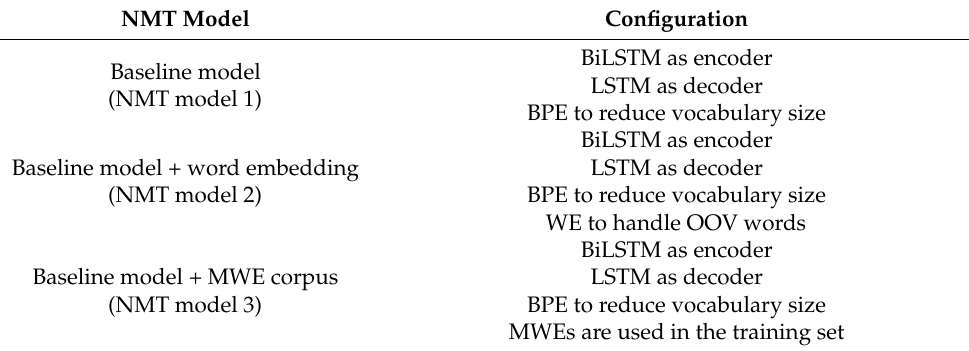
Table 8. Configuration of different NMT